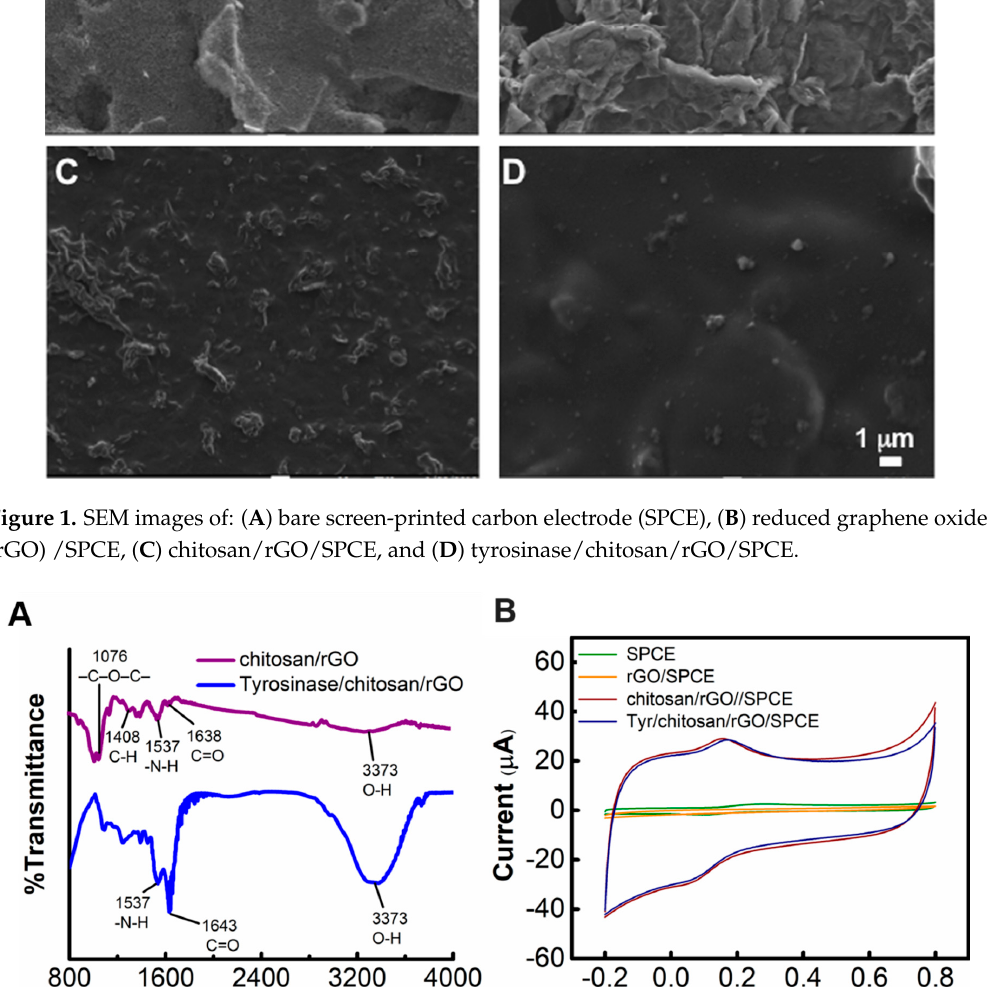
Figure 1. SEM images of: ( A ) bare screen-printed carbon electrode (SPCE), ( B ) reduced graphene oxide (rGO) /SPCE, ( C ) chitosan/rGO/SPCE, and ( D ) tyrosinase/chitosan/rGO/SPCE.